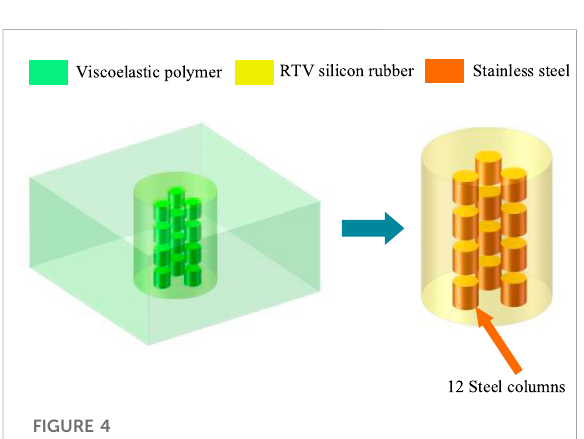
FIGURE 4 Schematic diagram of SAM with multiple resonance